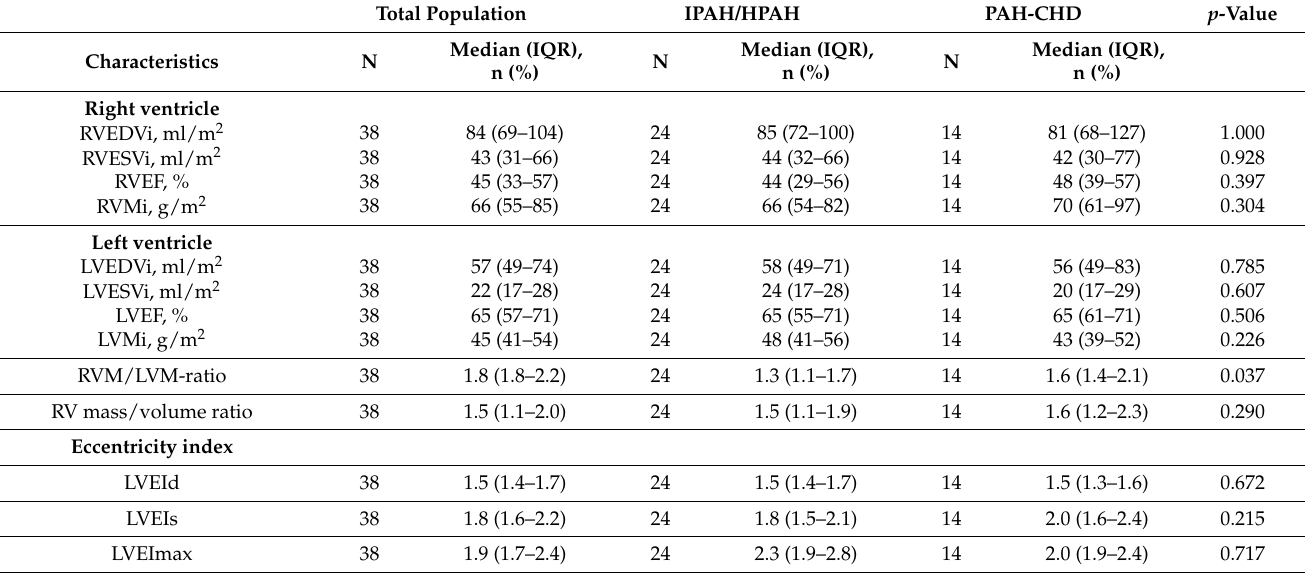
Table 2. Cardiac magnetic resonance measurements.